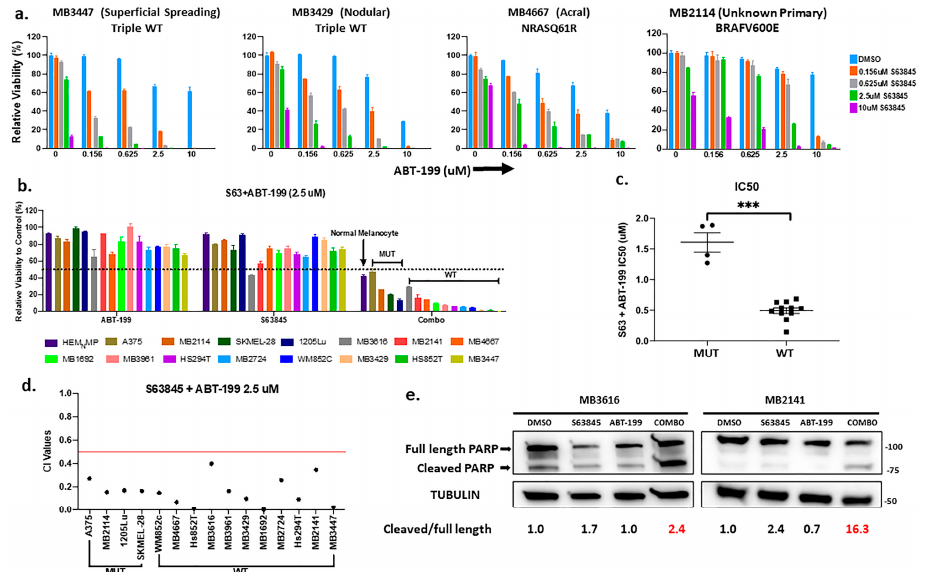
Figure 2. The combination of the BCL2 inhibitor ABT-199 with the MCL1 inhibitor S63845 had high efficacy in advanced melanomas in vitro. ( a ) ATP assays for various subtypes of melanoma patient samples and normal human melanocytes upon indicated treatments for 48 h. The viability of the DMSO control for each cell line was set to 100%. The viability of almost all combinational treatments was statistically significantly different from those of control or single drugs. For clarity and readability, we listed p values of all comparisons in Table S4 instead of showing an asterisk on figure. ( b ) Summary of ATP assay data of fifteen melanoma cell lines and patient samples and one primary melanocyte line treated with vehicle, single drug or combination of S63845 + ABT-199 at a dose of 2.5 μ M. Black dotted line indicates 50% relative viability. ( c ) Dot plot of IC50 values for combination treatment in BRAF-V600E-MUT and BRAF-WT lines. Each dot represents one cell line. ( d ) Dot plot with the Combination-Index (CI) of the drug combination at 2.5 μ M dose calculated using Compusyn software (version 1) (http://www.combosyn.com/) CI values < 0.5 (red line) indicate very strong synergism. Smaller CI values indicate stronger synergy. For visual clarity, the * is not shown in panels a and b. ( e ) Immunoblot with lysates collected after 48 h treatment with DMSO, single drugs, or combination at 0.625 μ M for each drug, and probed for poly ADP-ribose polymerase (PARP). The ratio of cleaved/full-length PARP in DMSO control was set as 1 within each cell line, and the relative ratios in all conditions were normalized to DMSO controls and listed at the bottom. The combination increased the ratio of cleaved/full-length PARP in both cell lines, indicating that apoptosis was activated. Molecular weight markers are in kDa. *** indicates p < 0.01.